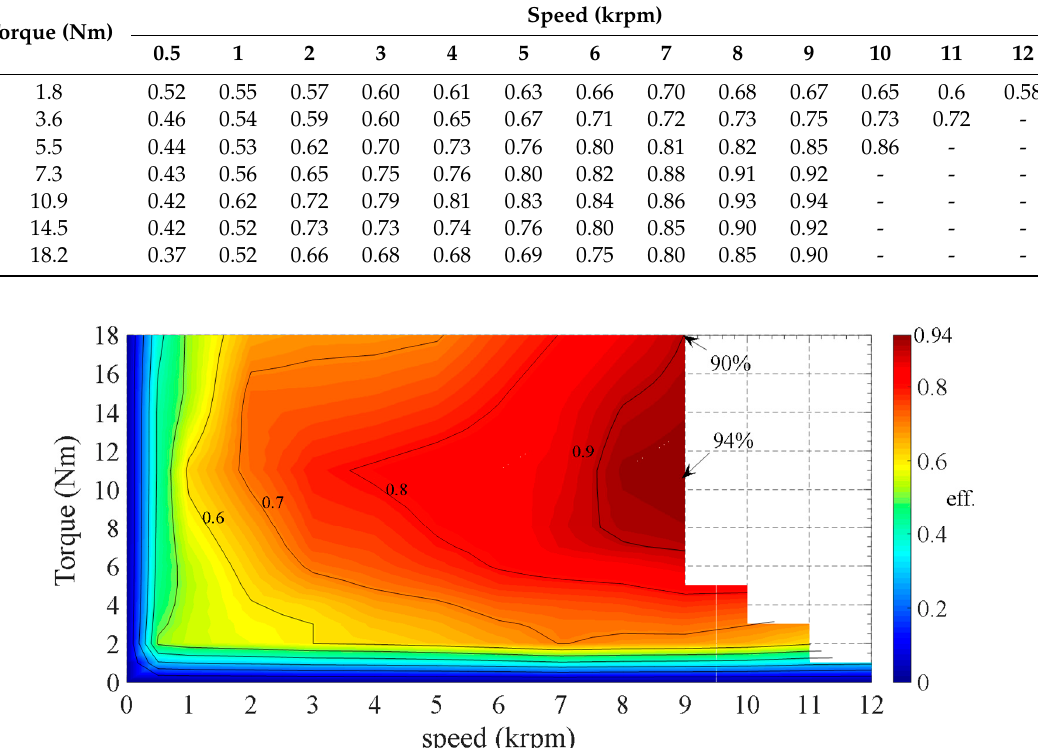
Figure 21. Experimentally estimated efficiency map.